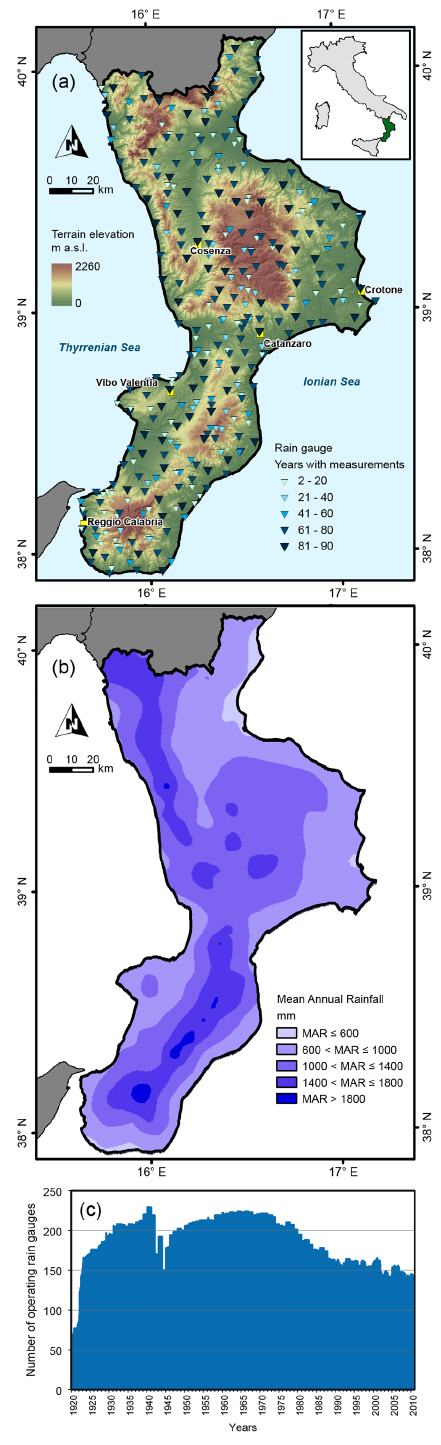
Figure 1. (a) Map of Calabria, southern Italy, showing terrain ele- vation (shades of green to brown), main cities (yellow squares), and location of rain gauges used in the study (triangles). Shades of blue show number of years with measurements for each rain gauge, in five classes. (b) Map of mean annual rainfall (MAR) in Calabria, in five classes. (c) Number of operating rain gauges per year in Cal- abria between 1920 and